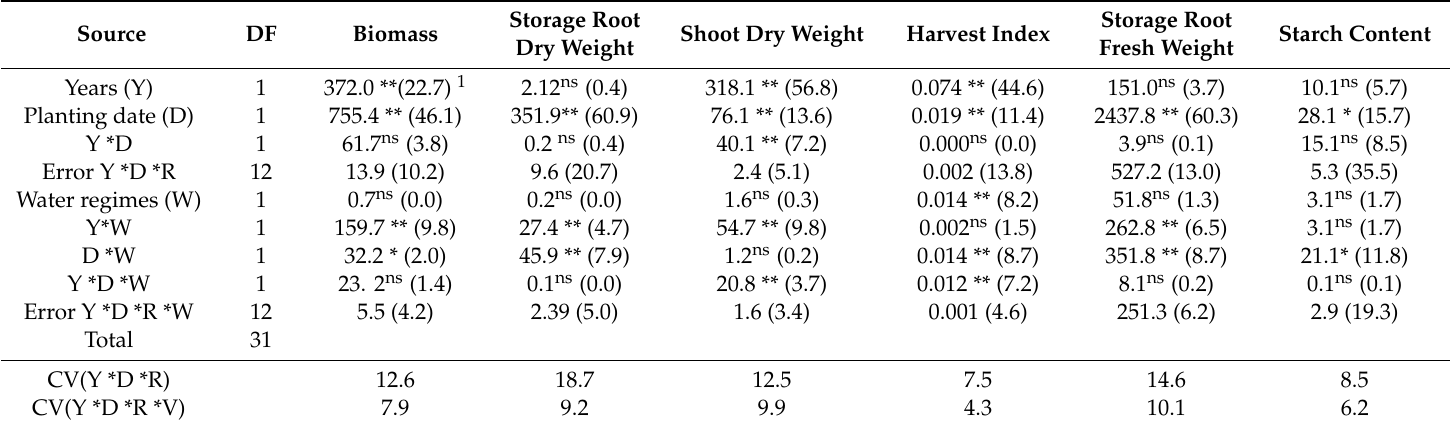
Table 5. Mean squares from combined analysis of Rayong 9 cassava under irrigated and rainfed conditions at planting dates May and November 2015 and